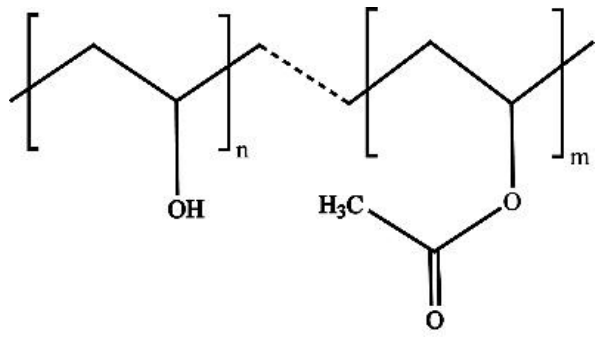
Figure 2. Schematic diagram of PVA and PVAc coexistence.